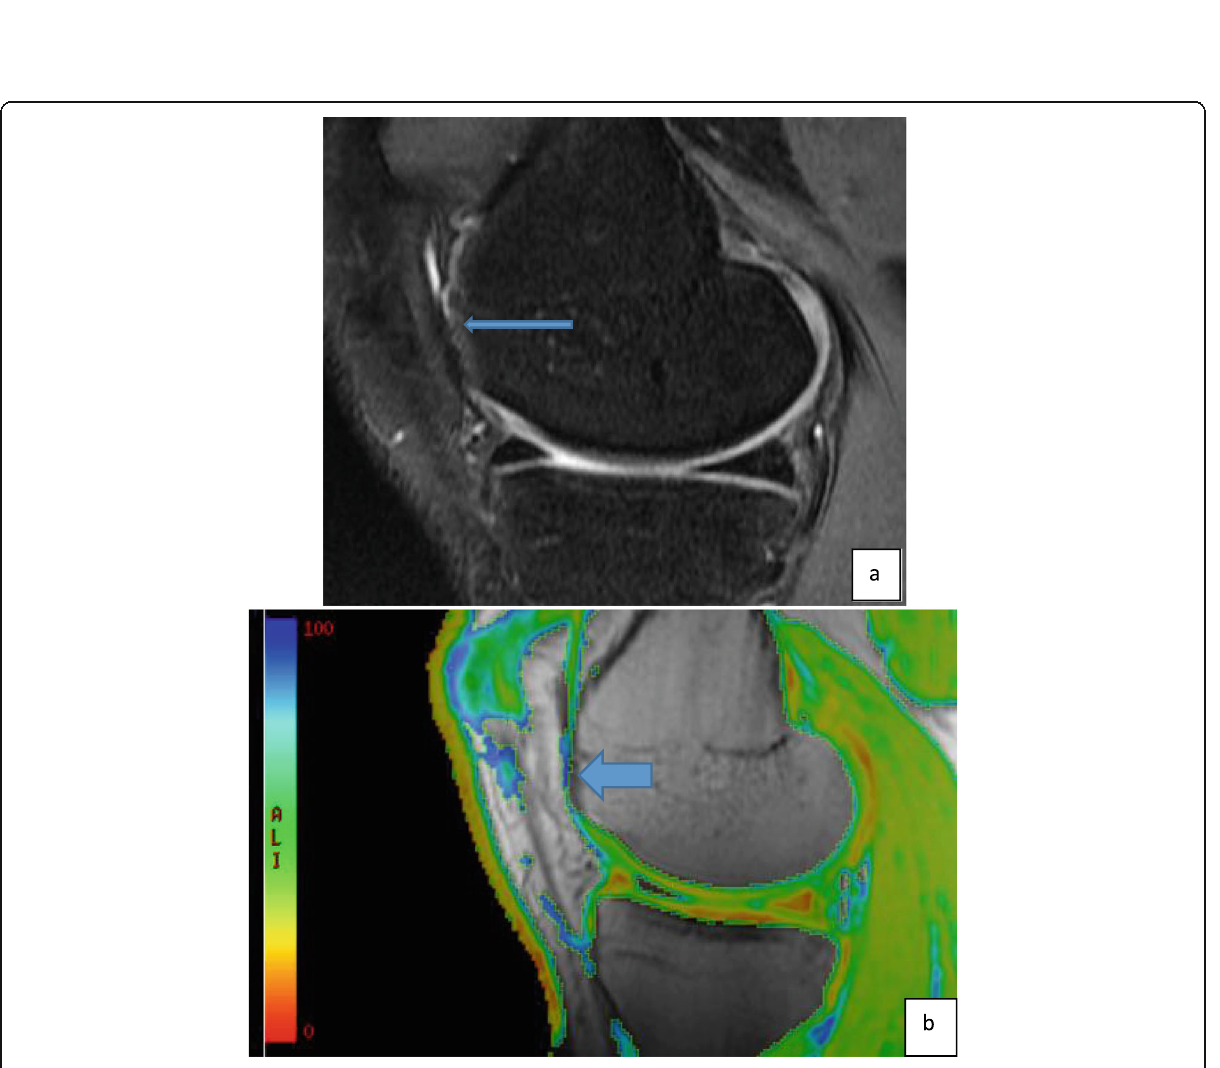
Fig. 4 Decreased bright hyperintense signal of cartilage covering the medial tibiofemoral condyle with decreased cartilage thickness (arrow) ( a ). Elevated color-coded values of cartilage (superficial zone aqua/blue and deep zone aqua/blue with no associated bone degeneration) covering the medial tibiofemoral condyle ICRS grade 3 (arrow) ( b